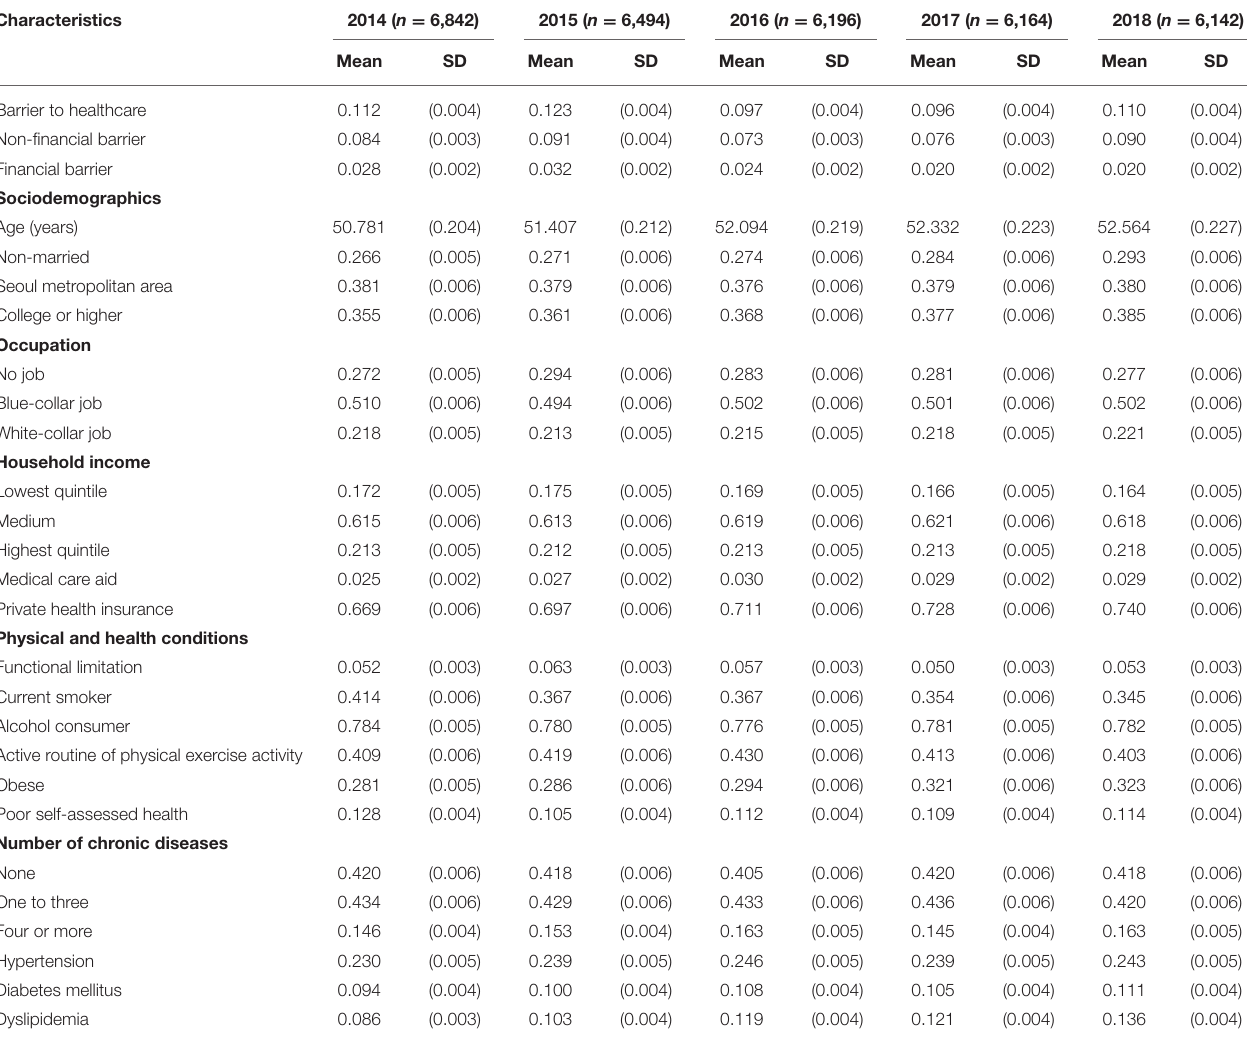
TABLE 1 | Sample characteristics and their descriptive statistics for each year among men.